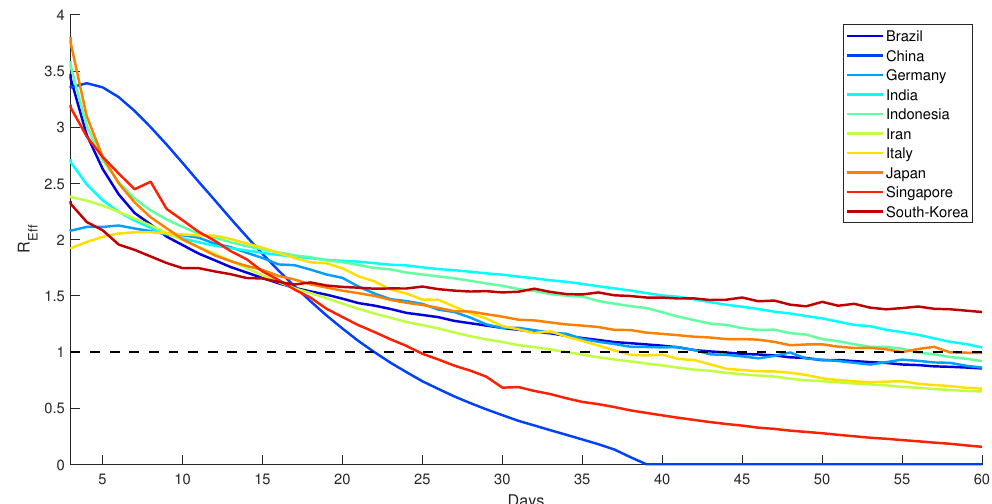
Figure 14. Effective reproduction number of countries, 60 days from the initial second wave of COVID-19 first